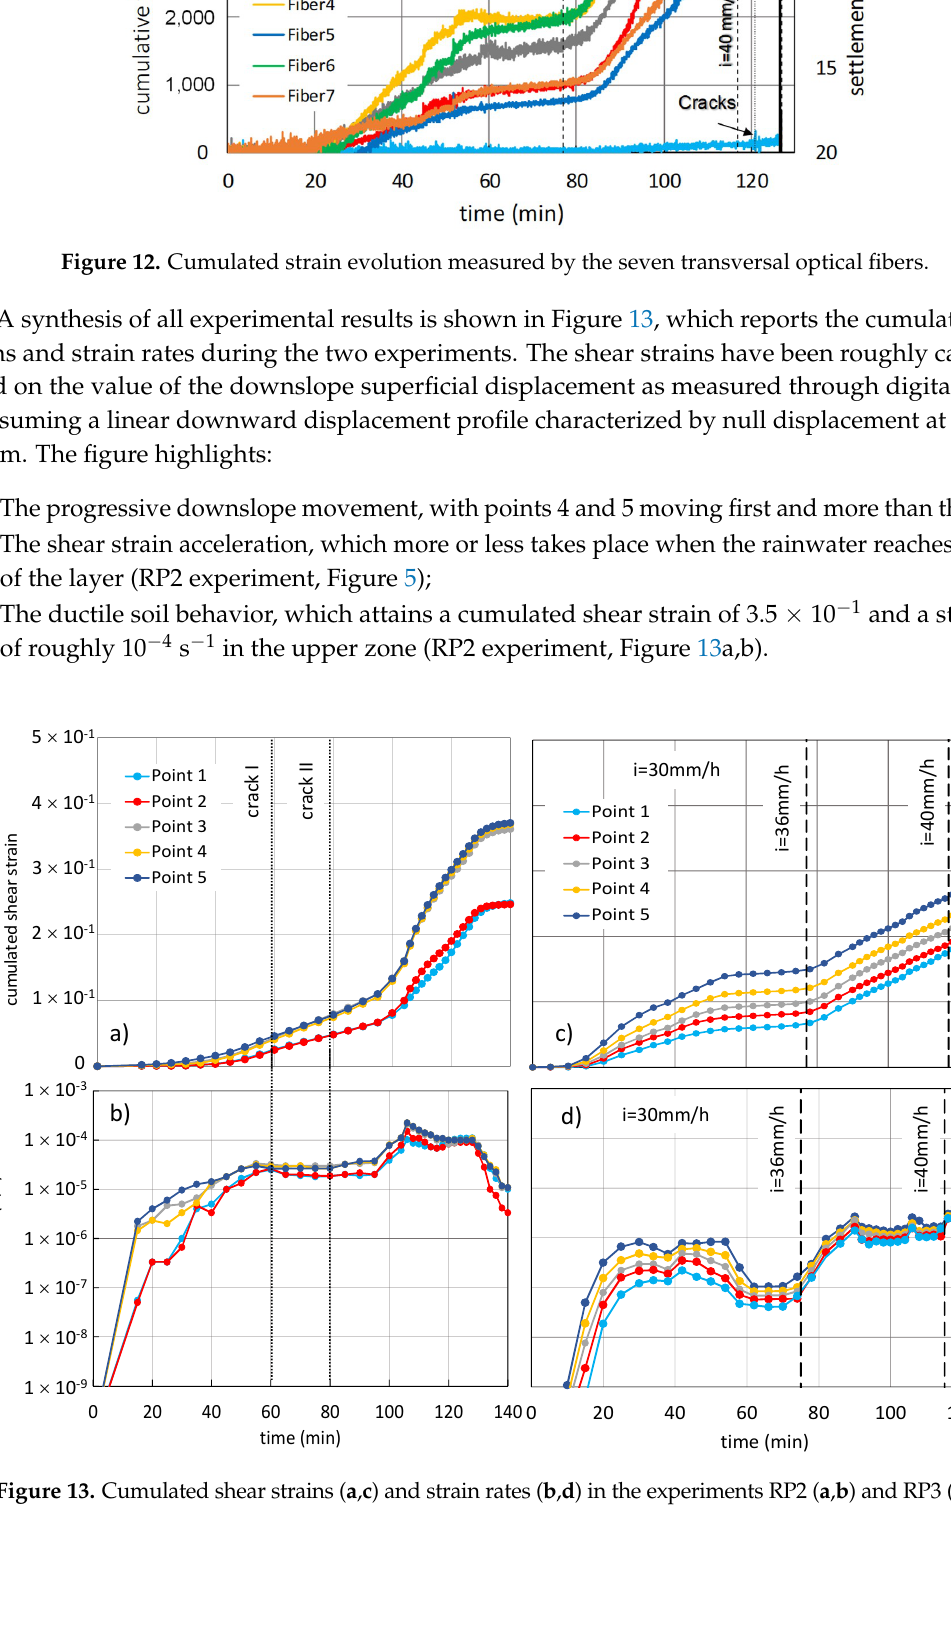
Figure 13. Cumulated shear strains ( a , c ) and strain rates ( b , d ) in the experiments RP2 ( a , b ) and RP3 ( c , d ).